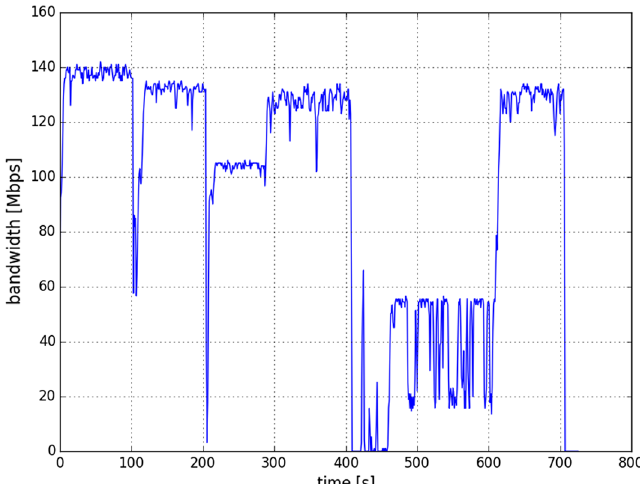
Fig. 22 Link performance when moving user-side OFEs, blocking and unblocking one of the ceiling-side